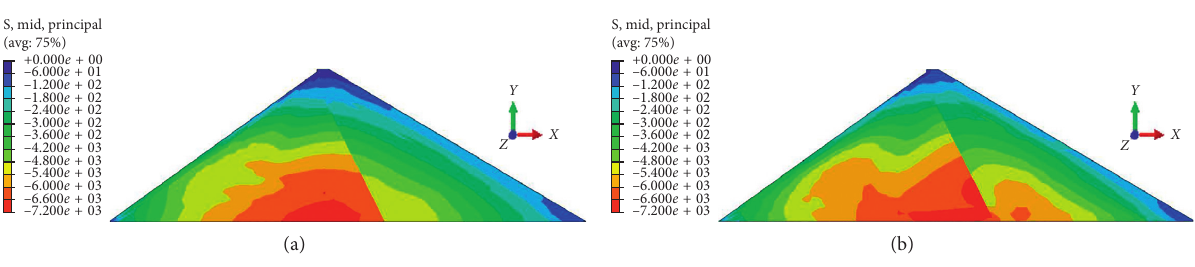
Figure 10: Minor principal stress nephogram at section D0+163.8 after 3 years of water storage. (a) Without creep. (b) Creep. Table 7: Maximum simulated calculation